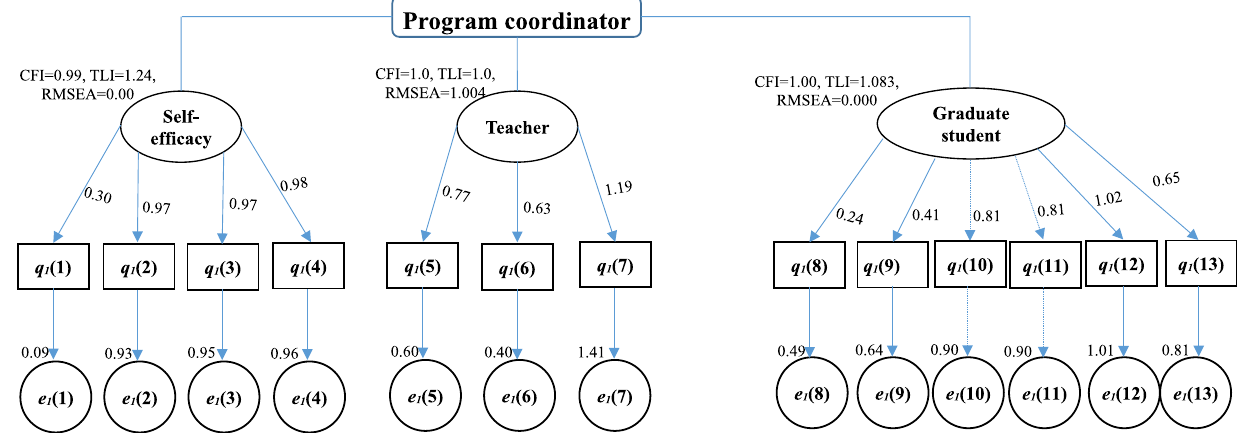
Fig. 2 Structural equation model describing the perceptions of program coordinator on the roles played by themselves, teacher and gradu- ate students for the GTA’s TPACK